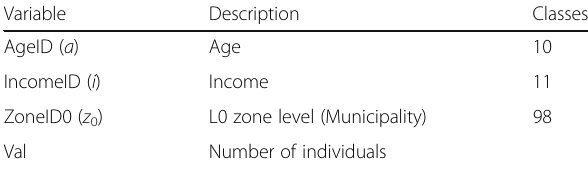
Table 5 Target T ai ( z 0, a , i ) for age, income and municipality level